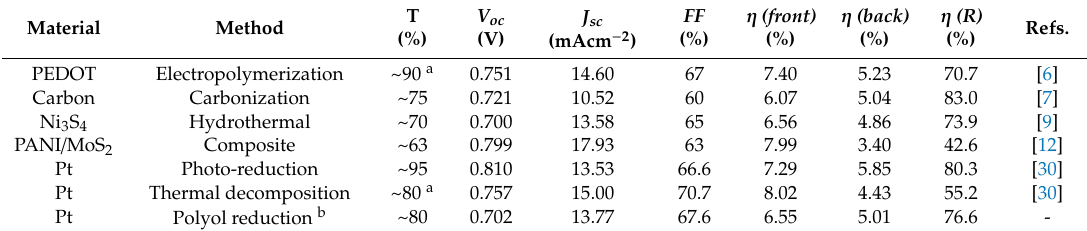
Table 4. Photovoltaic parameters of bifacial DSSCs with di ff erent CE materials.